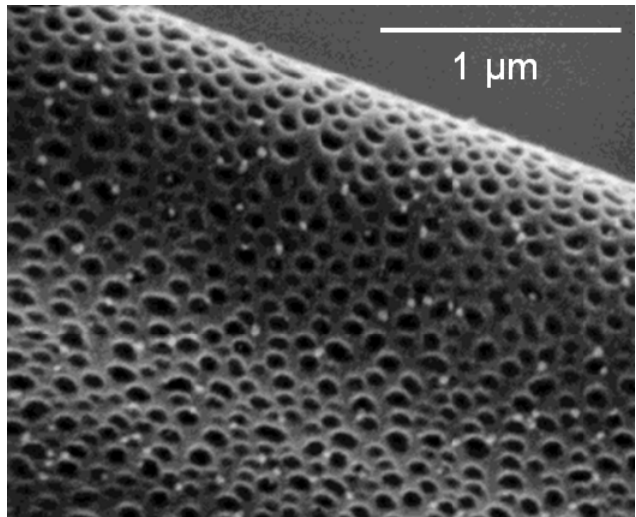
Figure 8. Scanning electron microscopy image of electrospun PS in THF at 50% relative humidity. (Reprinted with permission from Casper et al. [158]. Copyright 2004 American Chemical